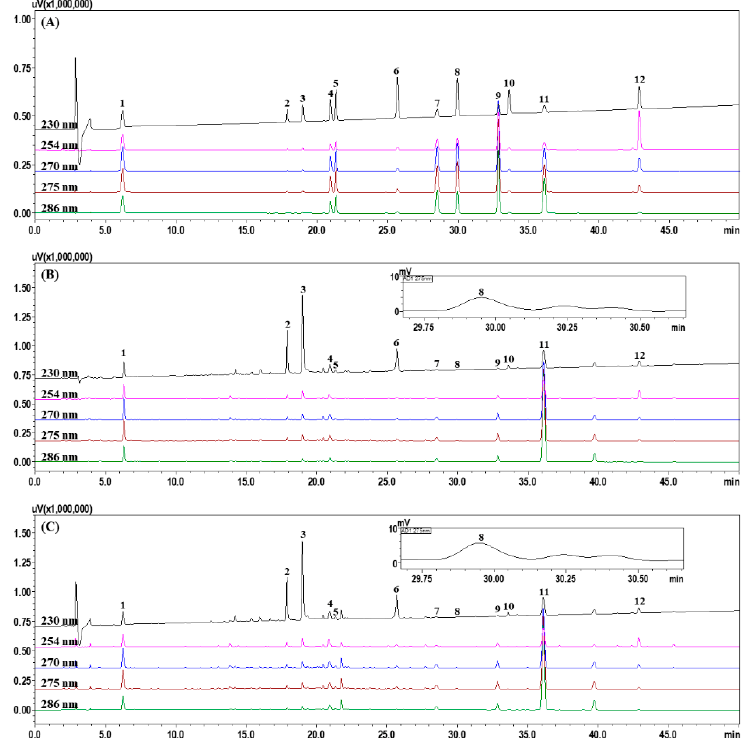
Figure 1. High-performance liquid chromatography (HPLC) chromatograms of mixtures of